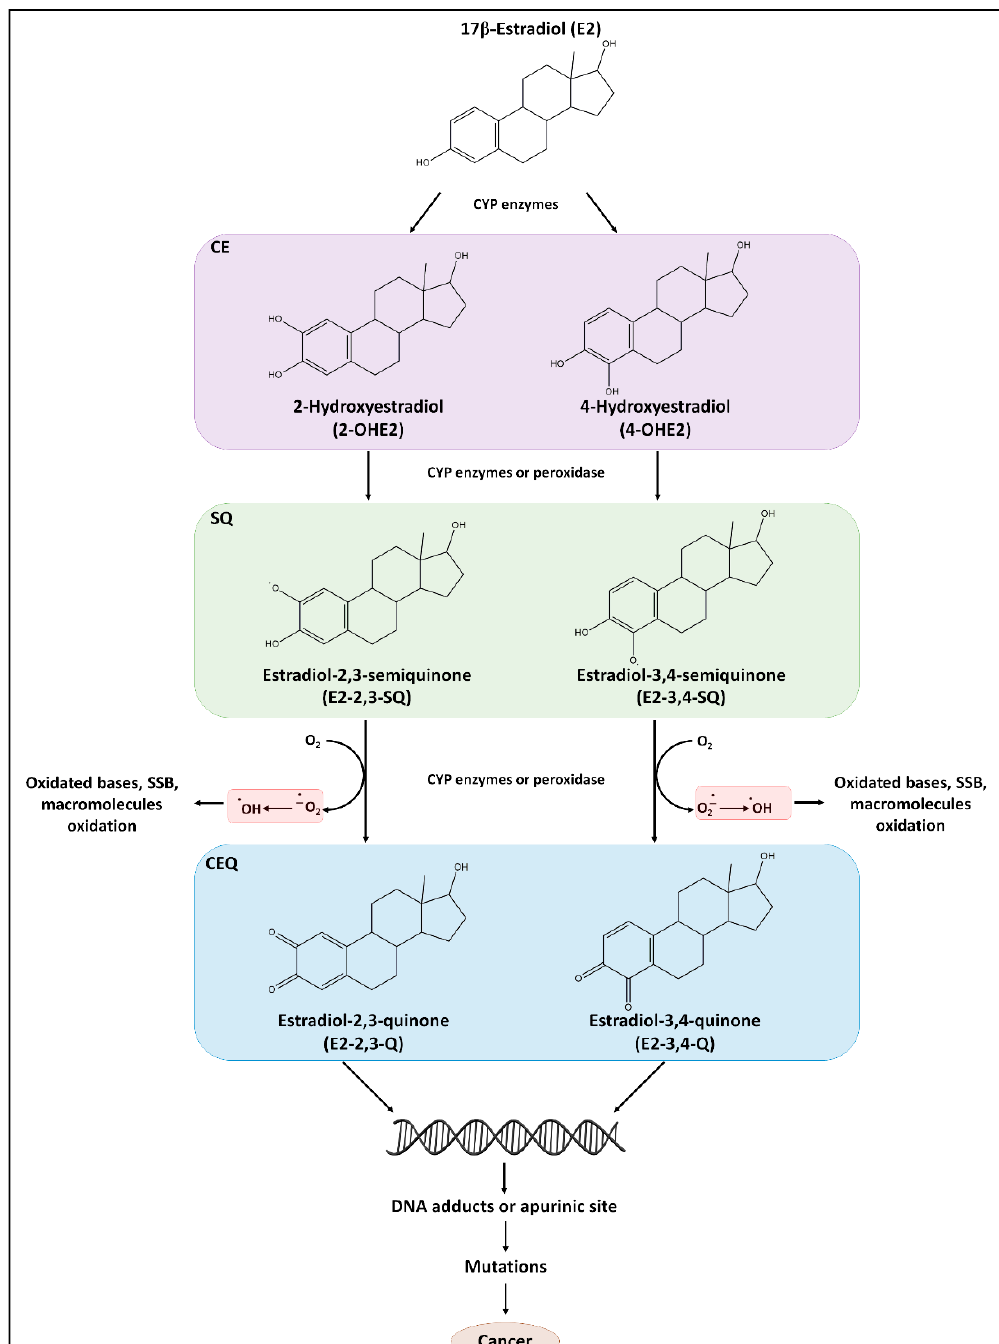
Figure 4. Metabolic byproducts of 17 β -estradiol (E2) exerting genotoxic effects. 17 β -estradiol (E2) is converted by cytochrome P450 (CYP)-dependent hydroxylation to 2-hydroxyestradiol (2-OHE2) and 4-hydroxyestradiol (4-OHE2). CYP enzymes or peroxidases convert these substrates into semiquinones (SQ), which may react with O 2 to generate superoxide radicals (OH•) that are highly reactive and induces proteins and lipids oxidation, DNA bases oxidation, and single-strand breaks (SSB). SQ can be also converted to quinones (Q) that can covalently bind DNA thus inducing DNA and/or chromosomal damage. Overall, these events cause genome instability and cell transformation. For details, see the text. The E2-induced-DNA damage is not restricted to the above-mentioned DNA-ad- ducts. Indeed, reactive oxygen species (ROS) produced during E2 metabolization are po- tent inducers of oxidized bases (e.g., 8-hydroxy-2’-deoxyguanosine (8-OHdG), 5-hy-